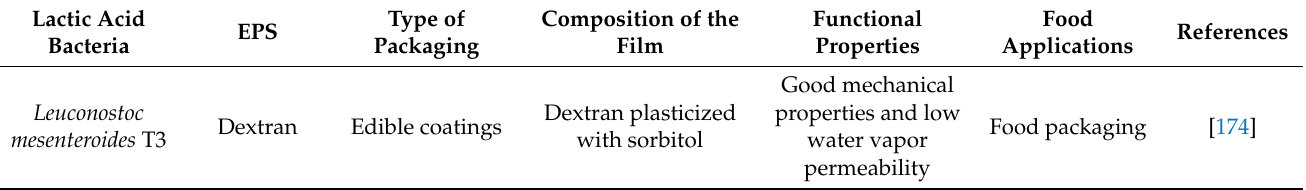
Table 5. Applications of EPS produced by lactic acid bacteria in the food packaging industry. Lactic